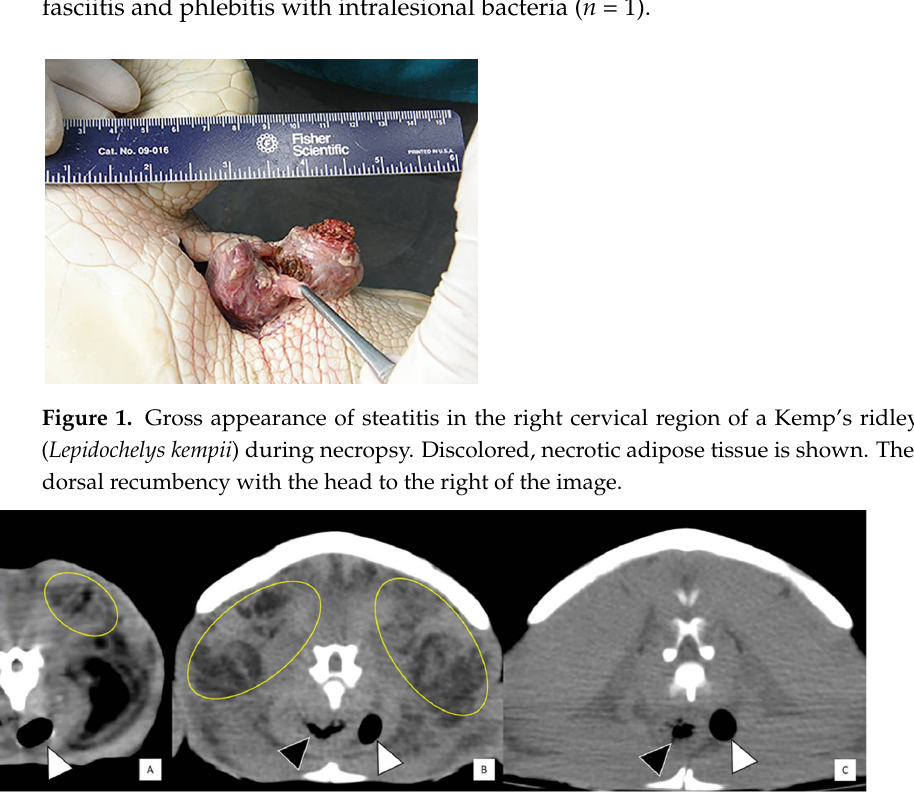
Figure 2. Transverse computed tomographic studies showing heterogeneous soft tissue density (yellow circled areas) consistent with steatitis in the cranial cervical region ( A ) and pre-scapular region ( B ) of two Kemp’s ridley sea turtles ( Lepidochelys kempii ). ( C ) The same turtle shown in ( B ) at approximately the same anatomic location after resolution of disease four months later. Black arrowhead: esophagus, white arrowhead: trachea. Table 2. Histopathologic findings in steatitis lesions of nine cold-stunned Kemp’s ridley sea turtles ( Lepidochelys kempii ) examined by surgical biopsy ( n = 6) or post-mortem ( n =